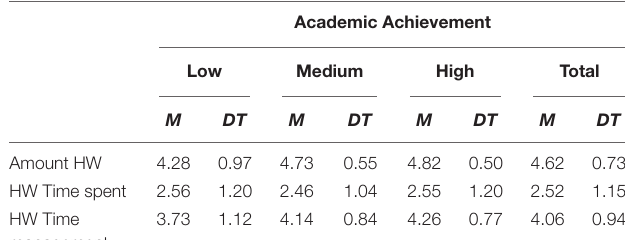
TABLE 3 | Descriptive statistics (mean, standard deviation) corresponding to each of the levels of prior academic achievement in the variables related to behavioral